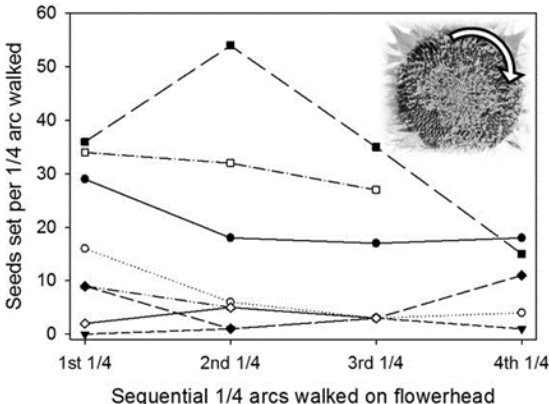
F IGURE 3. Changes in rates of achenes set by each female O. californica as she visited progressive ¼ arcs of receptive flowers on a single flowerhead. Only included are those eight females that walked at least ¾ of an arc and set five or more seeds. Inset Flowerhead with a broad ring of black, matured seeds resulting from a single Osmia visit. First ¼ arc of travel marked.